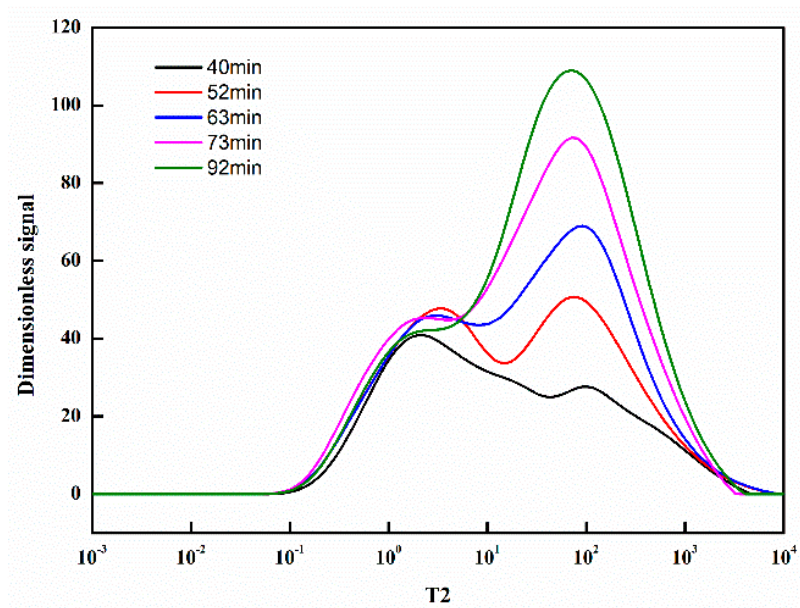
Figure 4. T2 spectrum of core 96 during the dynamic imbibition process.